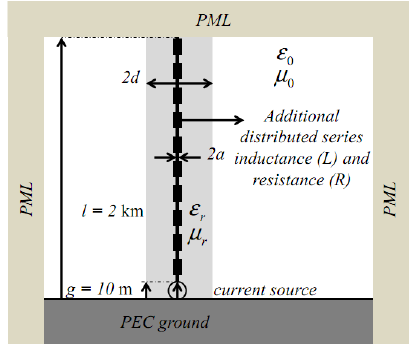
Figure 1. A vertical thin-wire monopole antenna with a fictitious dielectric coating surrounded by air over a flat PEC ground, excited at its base by a lumped current source.